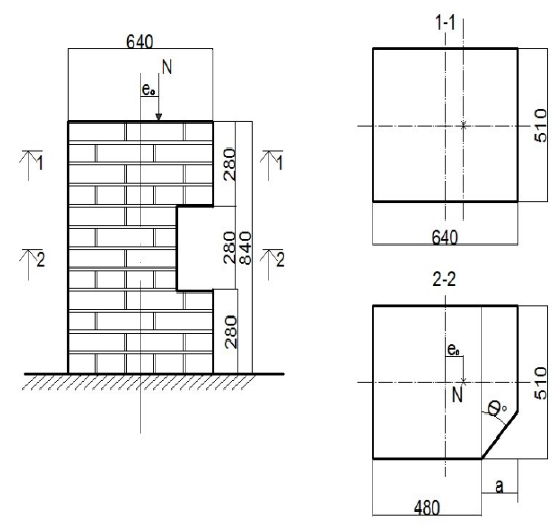
Figure 2 . Diagram of simulation of damaged